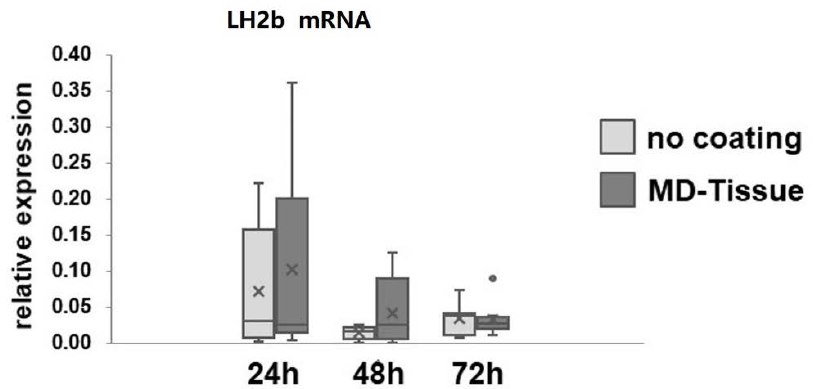
Figure 3. Bar graphs showing mRNA levels for Long lysyl hydroxylase 2 (LH2b) in NC and MD-Tissue tenocytes (COL) assessed by real-time PCR. Data were normalized on GAPDH gene expression and are expressed as mean ± SD for at least two independent experiments for the eight samples run in duplicate. ×: mean; •: outlier sample.